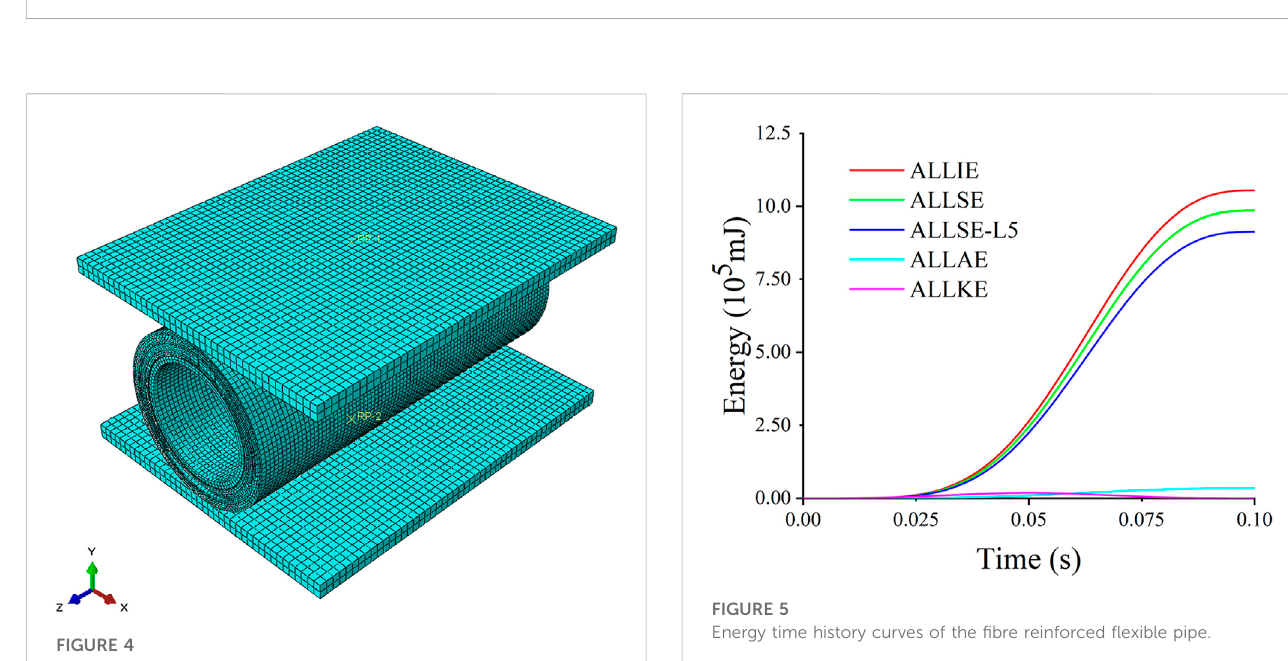
FIGURE 3 Sample and testing machine for the radial compression tests.